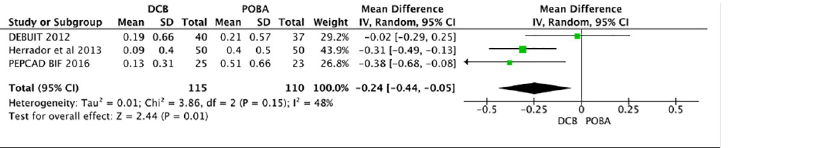
Fig 2. Forest plot for late lumen loss in DCB v POBA for side branch